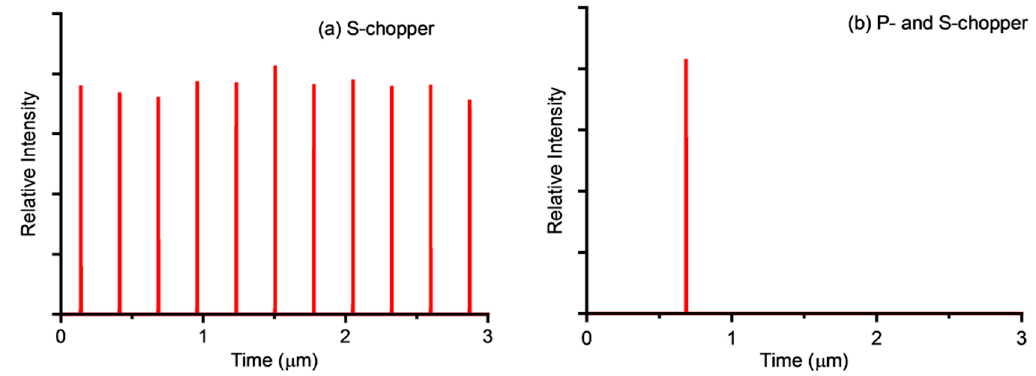
Figure 10. Beam pulse trains of the 65 MeV H + measured by a plastic scintillator. The intervals of the beam pulses were 43.7 ns ( T RF ) without chopper operation. ( a ) S-chopper was used at a reduction ratio of 1/5 ( T = 273 ns); ( b ) P- and S-chopper were used simultaneously at repetition period of the P-chopper of 4.37 μ s (80 × T RF ).